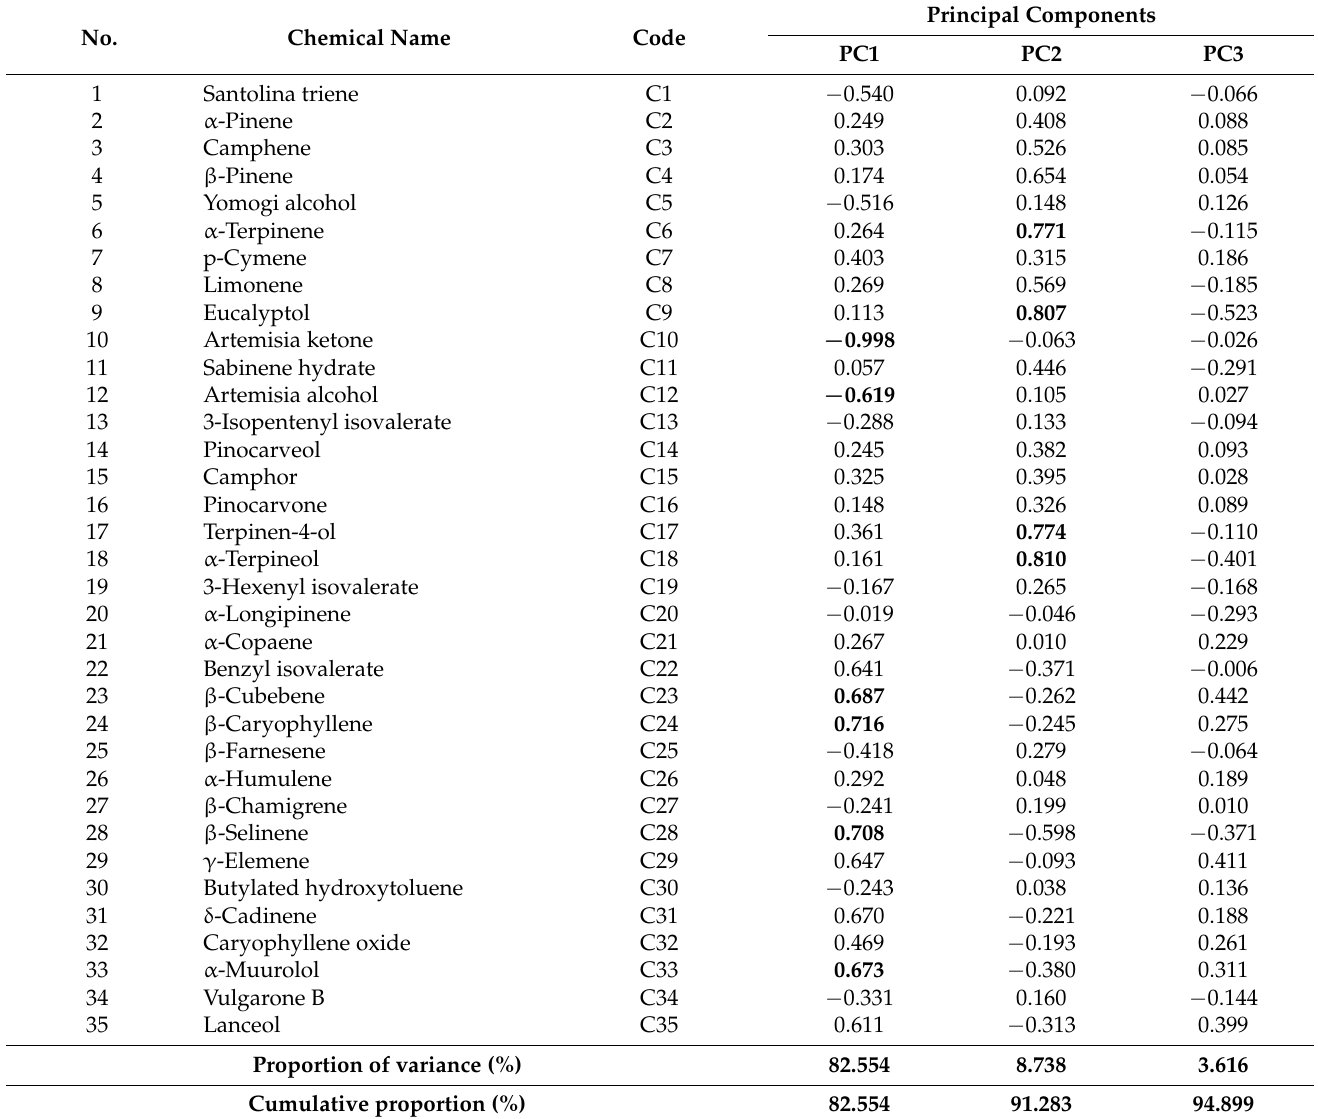
Table 4. Principal component scores of 35 common chemicals in the essential oils of Korean A. annua individuals.